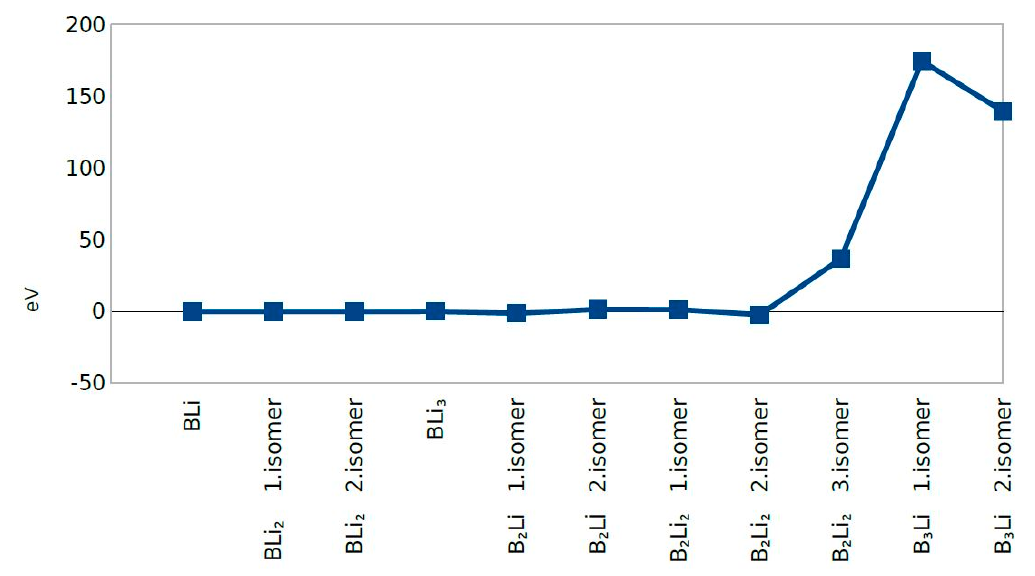
Figure 6. The Second Difference in Energy.